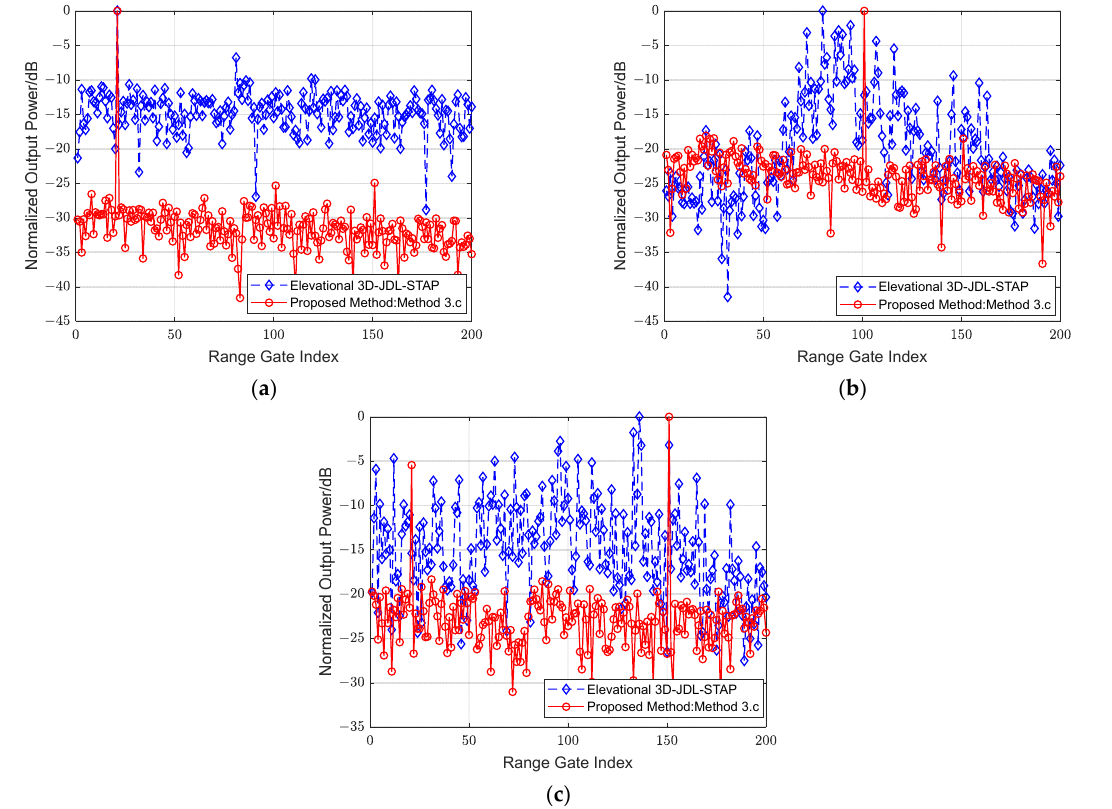
Figure 18. Normalized output power spectrum in different Doppler channels by different method: ( a ) Doppler channel of 1st target; ( b ) Doppler channel of 2nd target; ( c ) Doppler channel of 3rd target. In summary, the performance of moving target detection obtained by the proposed method and former clutter suppression methods for non-side-looking AEWRs are com- pared. After the clutter is suppressed by different methods, the detection performance obtained by the conventional C-FAR method is shown in Table 3, where the d represent the probability of detection and false alarm, respectively. Table 3. The performance of faint moving target detection by different methods. Method Target 1 Target 2 Target 3 FDA: Cascaded processing (method 2)